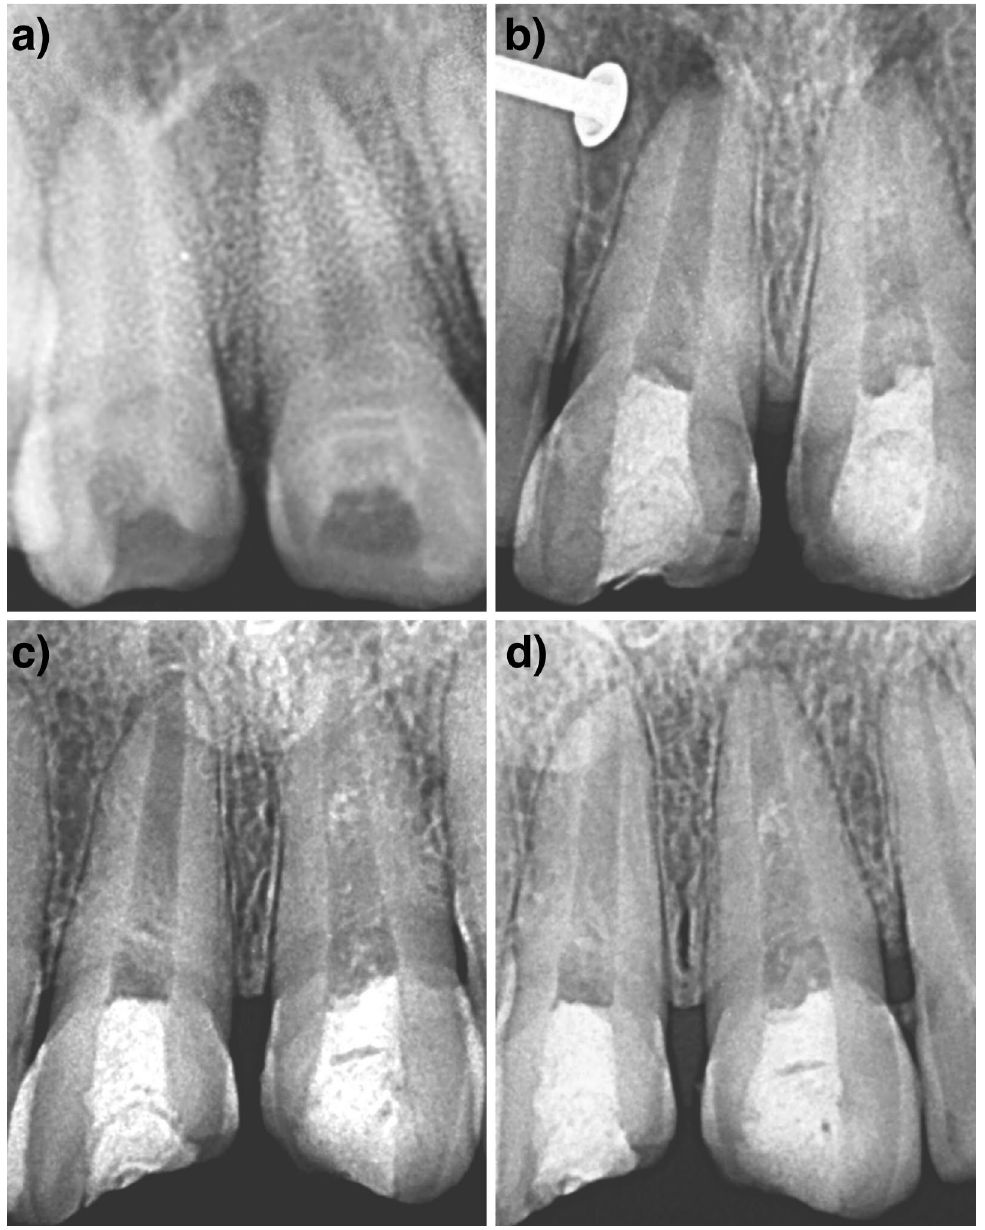
Figure 2. Case 1: Tooth no. 11, 21- ( A ) Preoperative radiograph; ( B – D ) Radiographs at 6 months, 12 months and 24 months follow-up